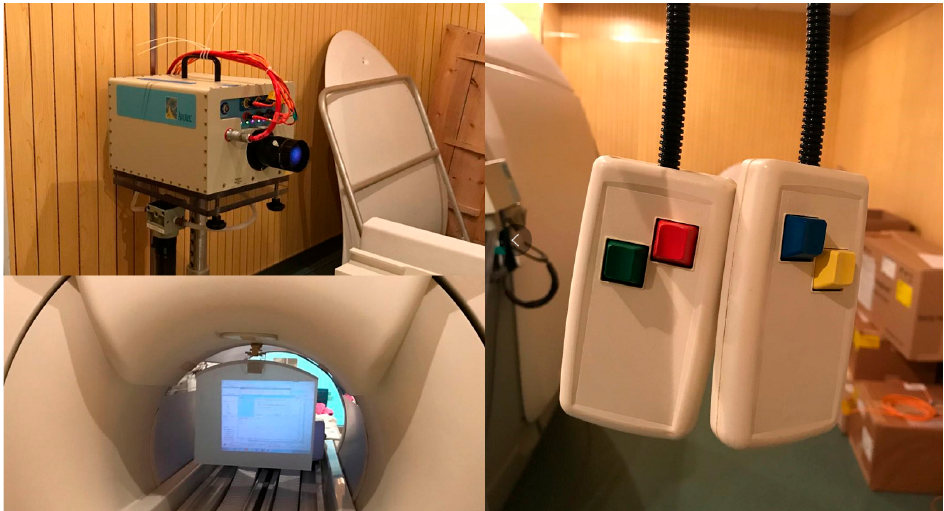
Figure 4. Projector, projection board and key boards.